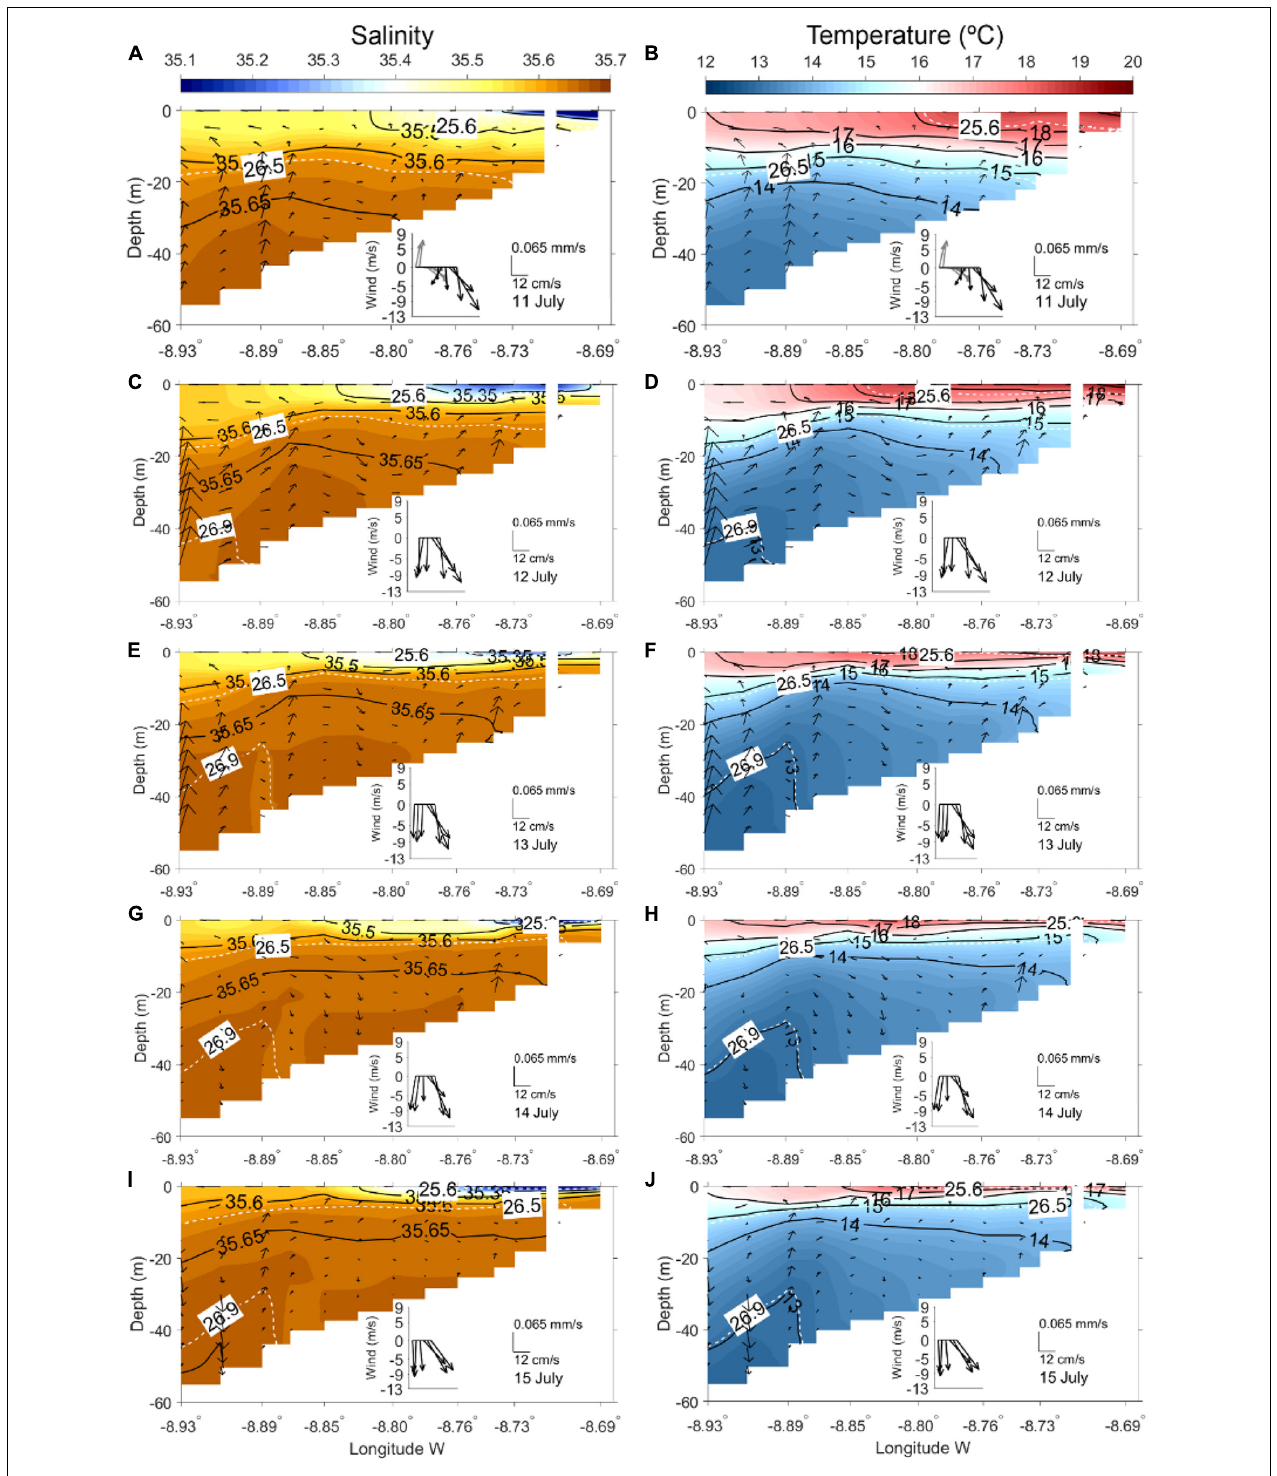
FIGURE 6 | Along-Ría section displayed in Figure 2 for daily mean salinity (A,C,E,G,I) and temperature ( ◦ C); (B,D,F,H,J) superimposed by sigma-t isolines, and subtidal velocity for along section (cm/s) and vertical directions (mm/s) with the corresponding scale as shown on 11, 12, 13, 14, and 15 July. Stickplot of wind evolution for every day at 1, 4, 9, 13, 16, and 21 h are represented inside each graphic and wind before the first day of the event is represented in gray colors for the previous day of the event.